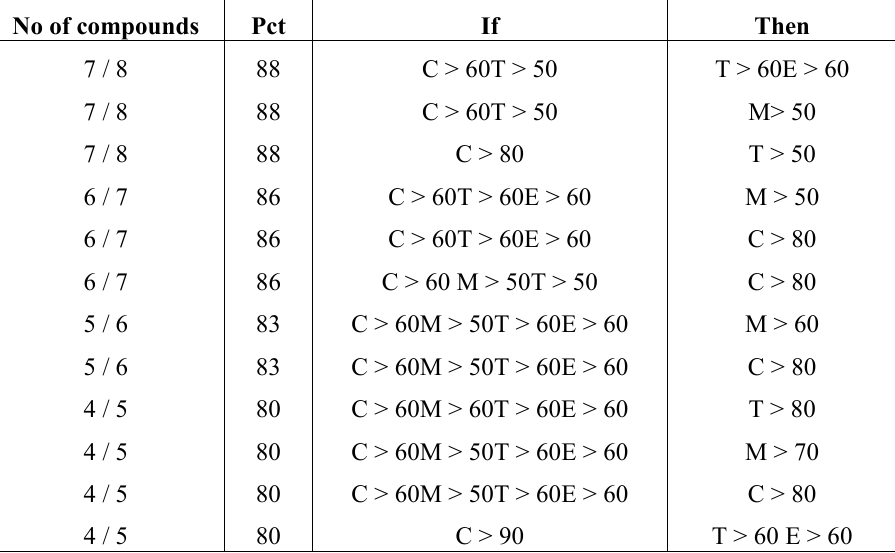
Table 10 . Selected association rules from the formal concept analysis of human health effects by 1,1-dimethyl hydrazine and its transformation products as derived by PASS